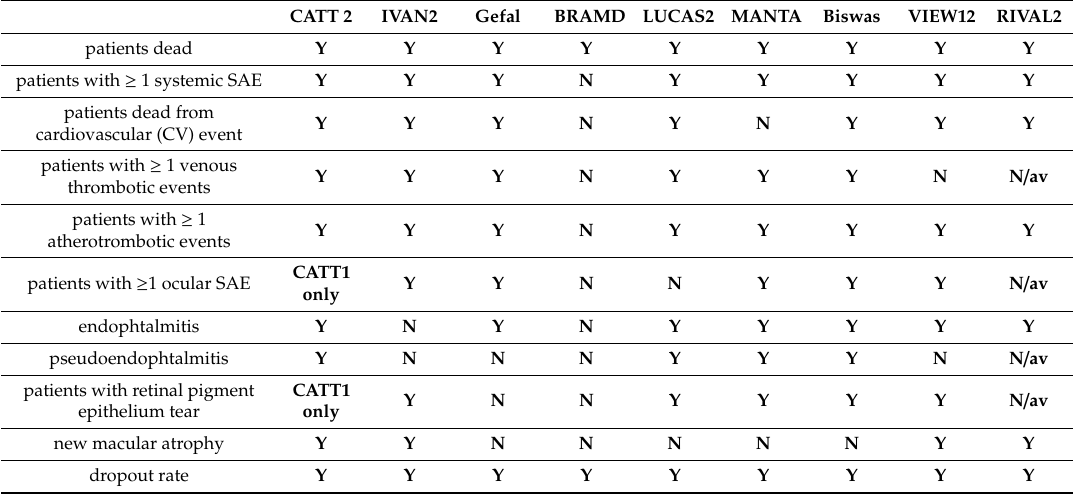
Table 4. Safety data availability across RCTs included into the analysis as per designed a priori outcomes (Y—data reported and N—data not available). SAE: serious adverse events. CATT 2